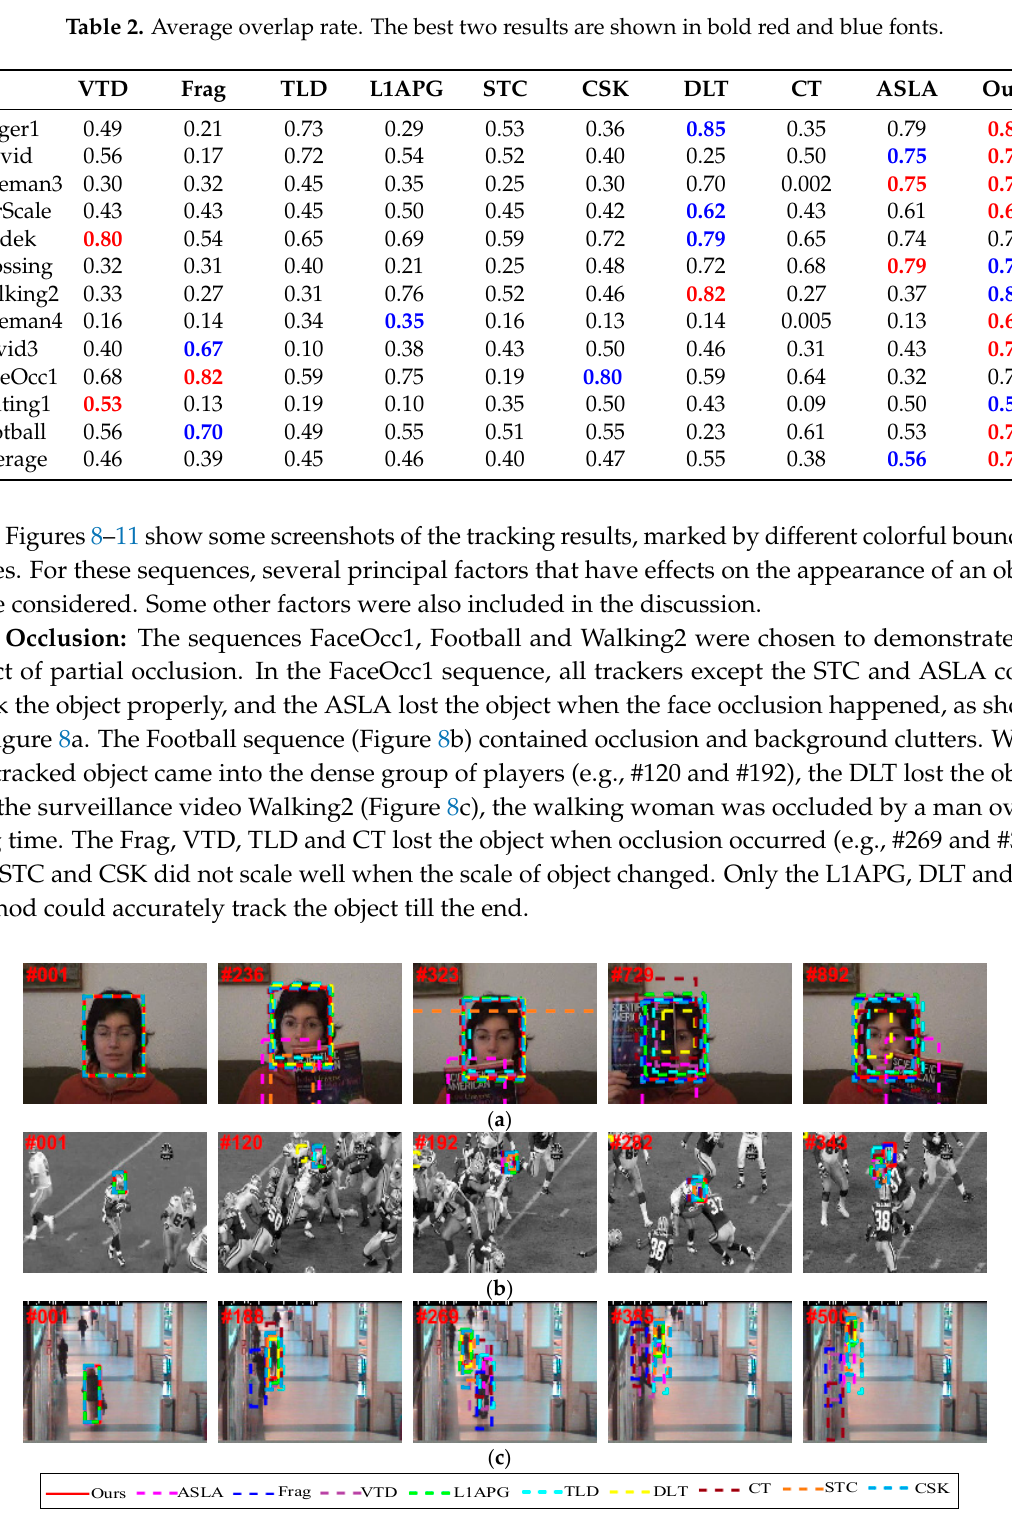
Figure 8. Screenshots of some sampled tracking results, where objects are heavily occluded. ( a ) FaceOcc1 with occlusion; ( b ) Football with occlusion and background clutters; ( c ) Walking2 with occlusion and scale variation.